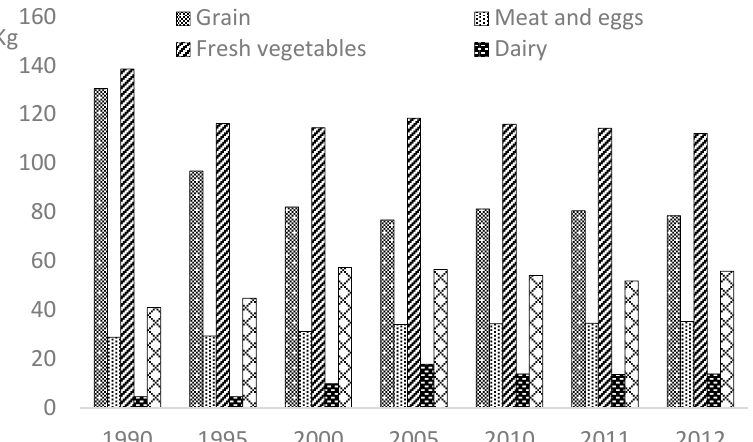
Figure 2. Per Capita Consumption of Major Food of Urban Households, 1990–2012. Note: The data are compiled on the basis of the integrated household income and expenditure survey of the National Bureau of Statistics of the People’s Republic of China, including urban and rural households.